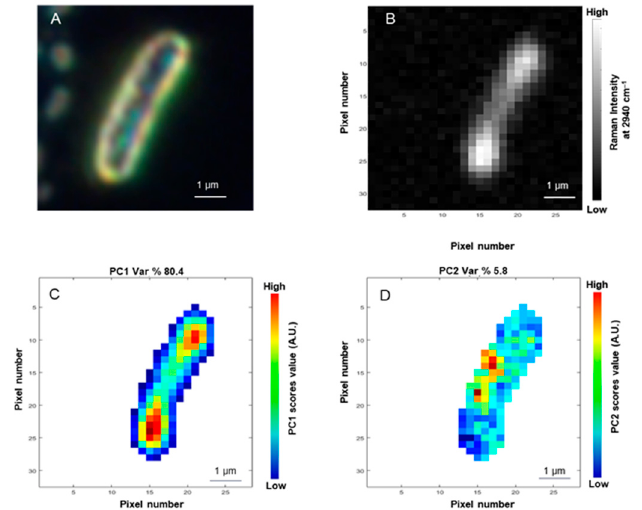
Figure 3. ( A ) Confocal Microscope image of a replicating E.coli cell spotted on a gold surface taken with a 100× microscope objective obtained in dark field. ( B ) Raman chemical map of a replicating E. coli cell colored on the basis of the Raman Intensity at 2940 cm − 1 . ( C ) Scores’ intensity of PC1 distribution. The color scale is based on PC1 scores’ intensity, from lowest ( blue ) to highest ( red ). ( D ) Score intensity of PC2 distribution. The color scale is based on PC2 scores’ intensity, from lowest ( blue ) to highest ( red ).